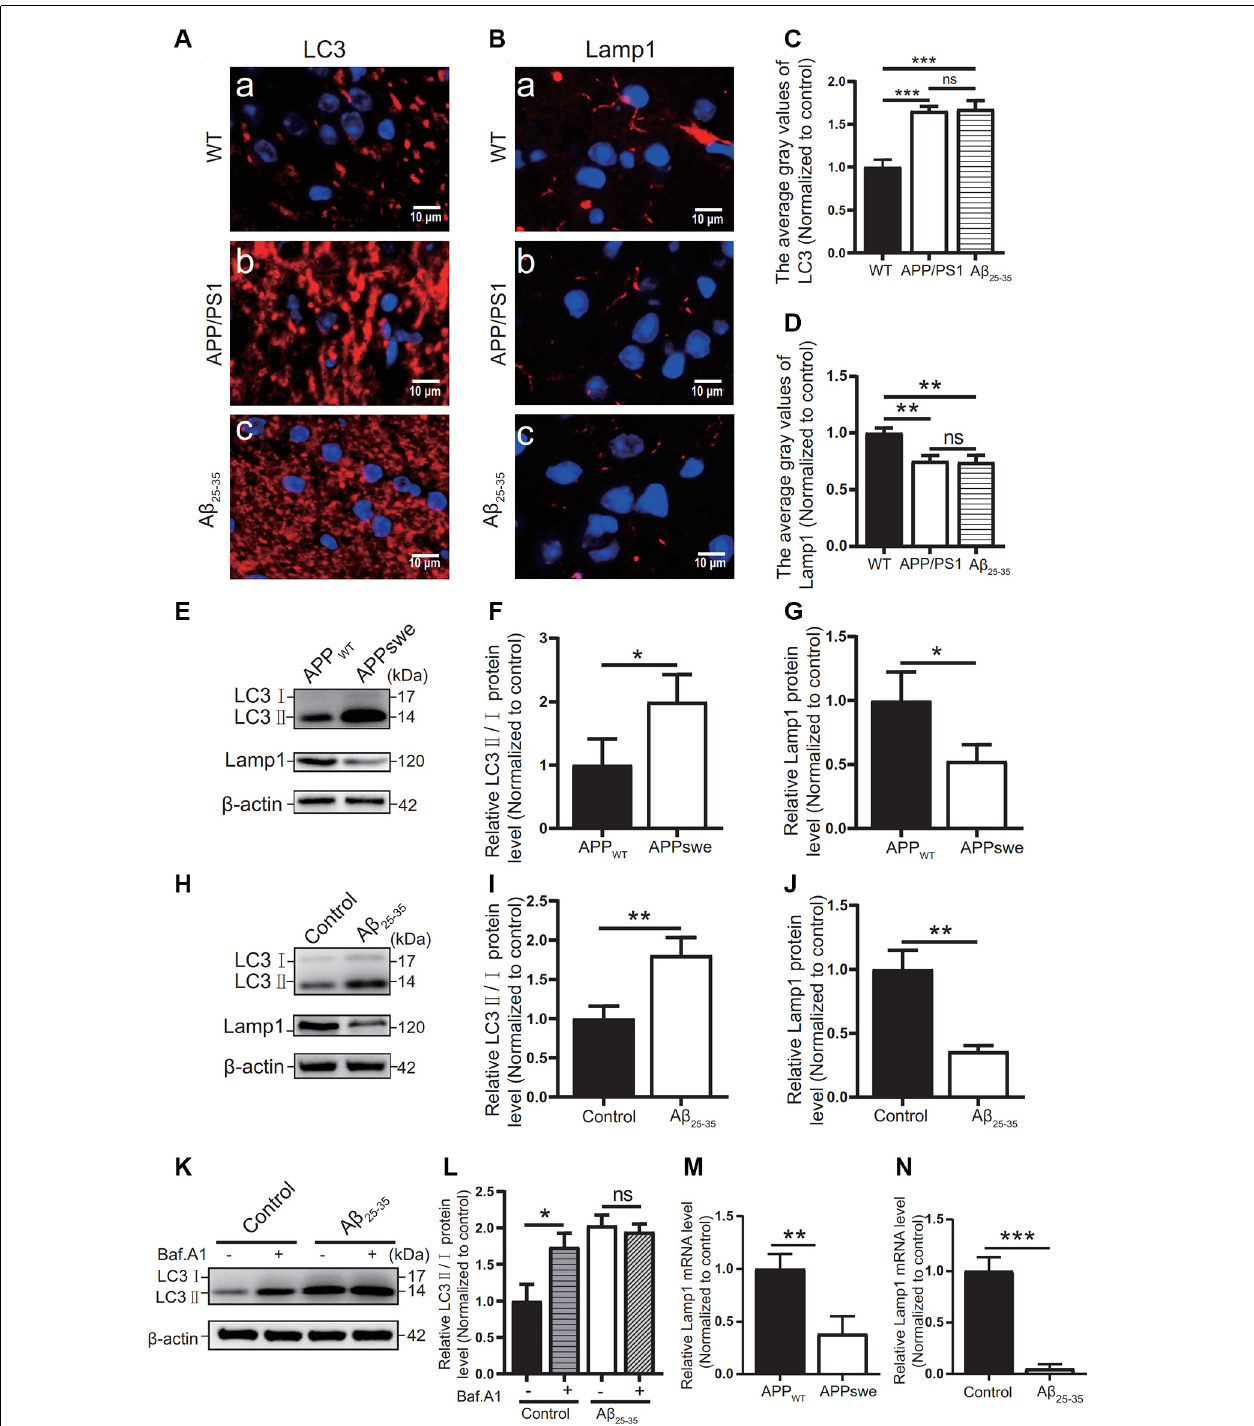
FIGURE 6 | Abnormal autophagic degradation in AD animal models and cell models. Immunofluorescence was used to observe the expression of the LC3 and Lamp1 proteins in the WT group, APP/PS1 group, and A β 25–35 group mice; the red fluorescence shows the immunofluorescence staining of LC3 (A,C) or Lamp1 (B,D) protein. (E) Western blot showing the expression of the LC3 and Lamp1 proteins in the APP WT group and APPswe group cells, (F,G) and the relative gray value of the protein. (H) Western blot showing the protein expression of LC3 and Lamp1 in the control group and A β 25–35 group cells. (I,J) The relative gray value of the protein. (K) Western blot showing LC3 protein expression in the control group and A β 25–35 group cells before and after adding bafilomycin A1, and (L) the relative gray value of each group was compared. (M,N) PCR quantitatively analyzed the mRNA expression of Lamp1 in the APPswe group cells or A β 25–35 group cells (* p < 0.05, ** p < 0.01, *** p < 0.001; “ns” means there is no significant difference; n =